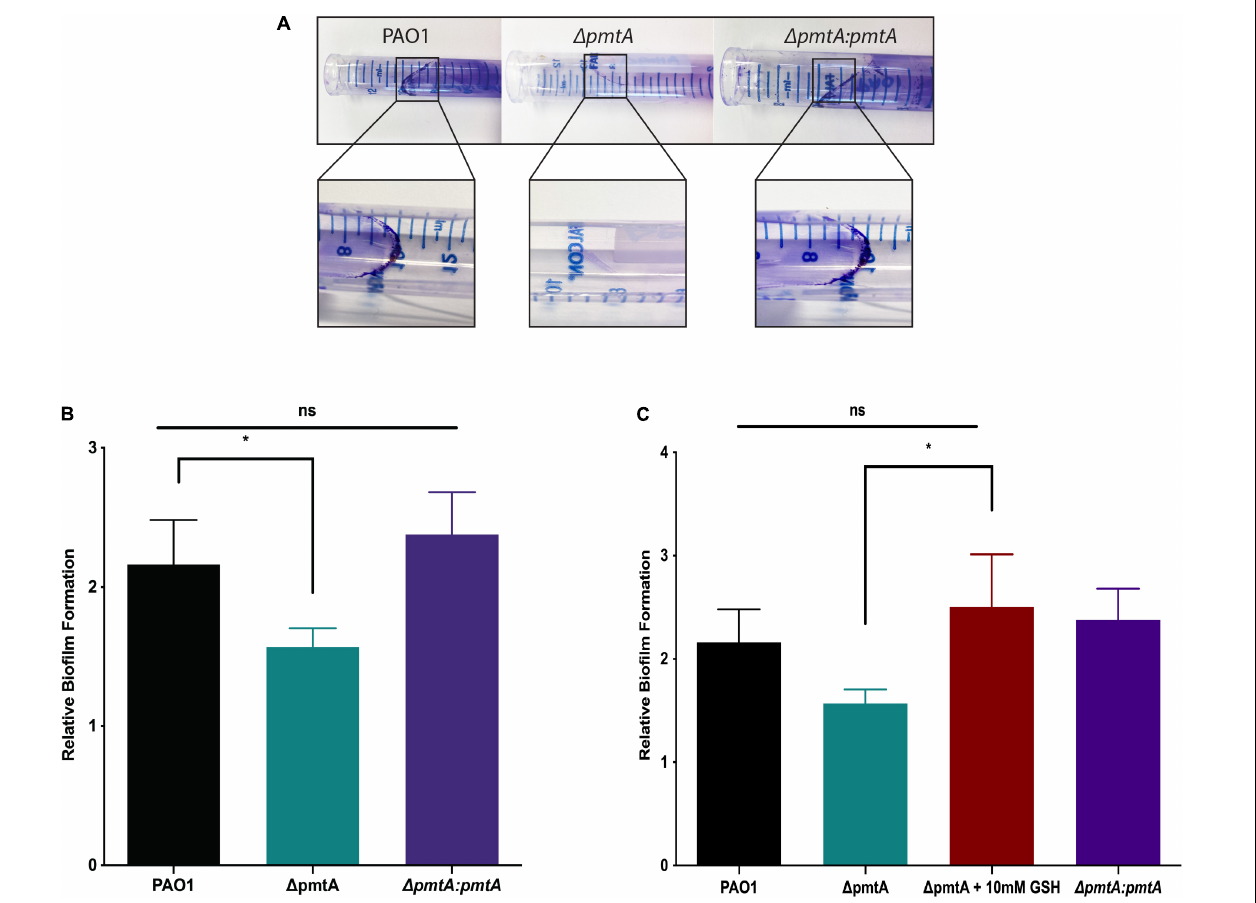
FIGURE 5 | PmtA is required for biofilm formation and the addition of antioxidant glutathione restores biofilm formation in P. aeruginosa (cid:49) pmtA mutant. (A) Cultures of P. aeruginosa strains were grown overnight in LB medium and stained with crystal violet. Less crystal violet was observed in the (cid:49) pmtA mutant when compared to wild-type and (cid:49) pmtA : pmtA PAO1 strains. (B) Cultures of P. aeruginosa strains were grown overnight in LB media, diluted 1:20 in fresh LB medium and grown to 0.5 OD 600 . After 24 h of growth, growth yield was measured at OD 600 . Biofilms were stained as previously described with minor modifications (O’Toole, 2010) and crystal violet stain was measured at OD 595 . The OD reading after the addition of crystal violet was divided by the growth yield OD to calculate the relative biofilm formation. (C) GSH at 10 mM was added to the LB media in the 96 well plate assay to determine if an antioxidant would rescue the biofilm formation defect in the (cid:49) pmtA mutant. GSH restored the biofilm formation of the (cid:49) pmtA mutant in the microtiter plate assay. An unpaired t -test analysis was performed (* p < 0.05; ** p < 0.01; *** p < 0.001; **** p < 0.0001). The data are presented as the average of three biological replicates ( ± standard error of the mean) and are representative of three separate experiments.